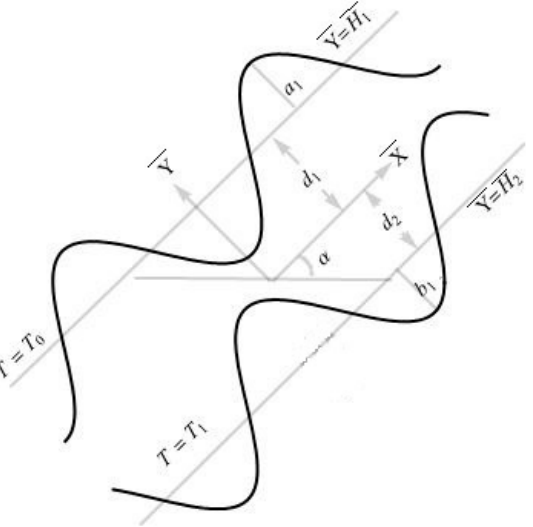
Figure 1. Peristalsis flow geometry.